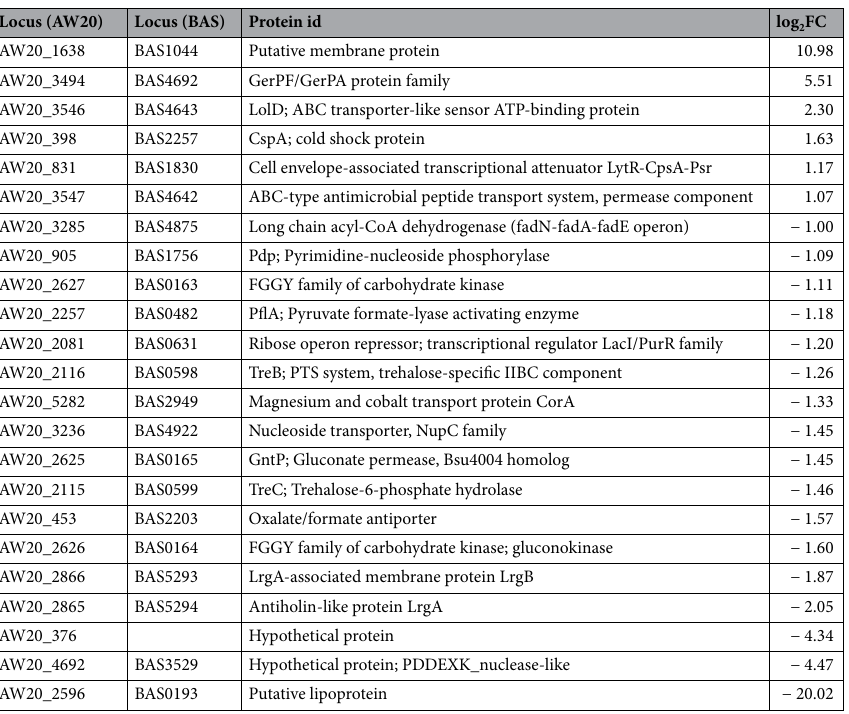
Table 2. Significant genes from the 30 min timepoint. Gene loci are listed according to NCBI Sterne RefSeq assembly GCF_000832635.1 (Locus AW20) with the RefSeq assembly GCF_000008165.1 loci provided (Locus BAS) where available. Protein name and functions are according to PATRIC and the log 2 FC are